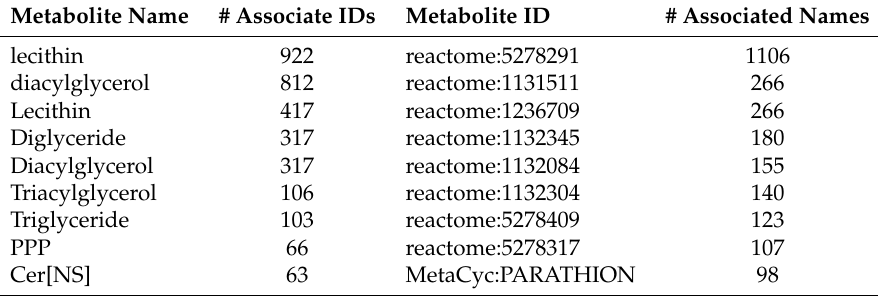
Table 3. Example of compound names and IDs with high ambiguity and